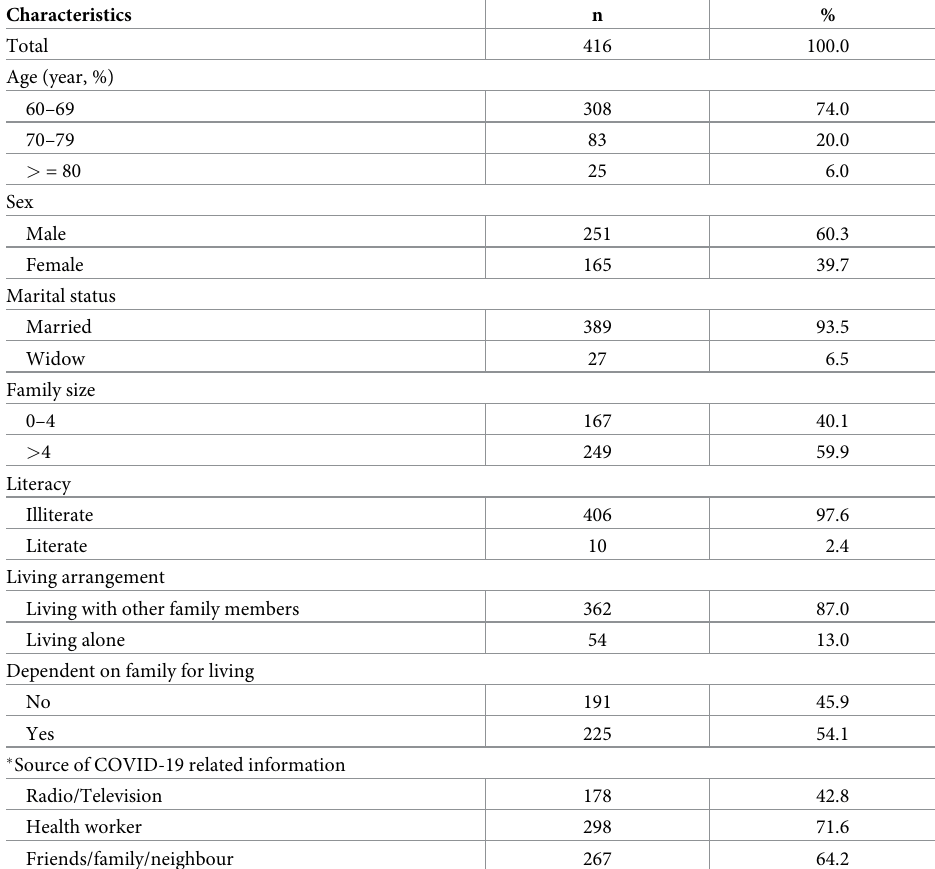
Table 1. Sociodemographic characteristics of the participants (N =